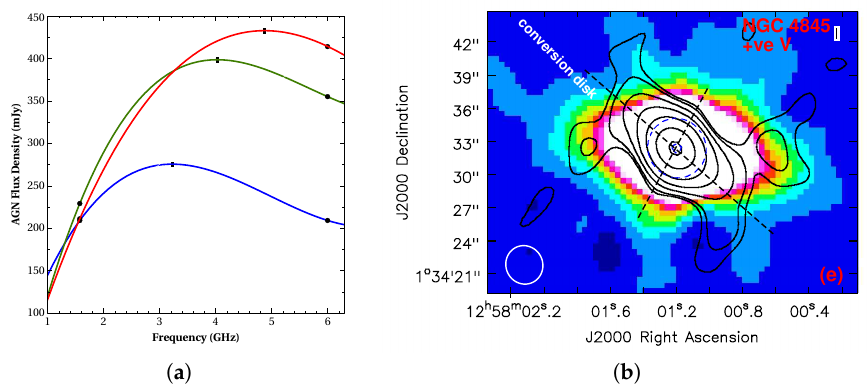
Figure 1. The galaxy, NGC 4845. ( a ) spectrum of the AGN in NGC 4845 from three different time steps, the earliest in red (T1), T1 + 56 days in green, and T1 + 196 days in blue, from [14]. ( b ) Contours